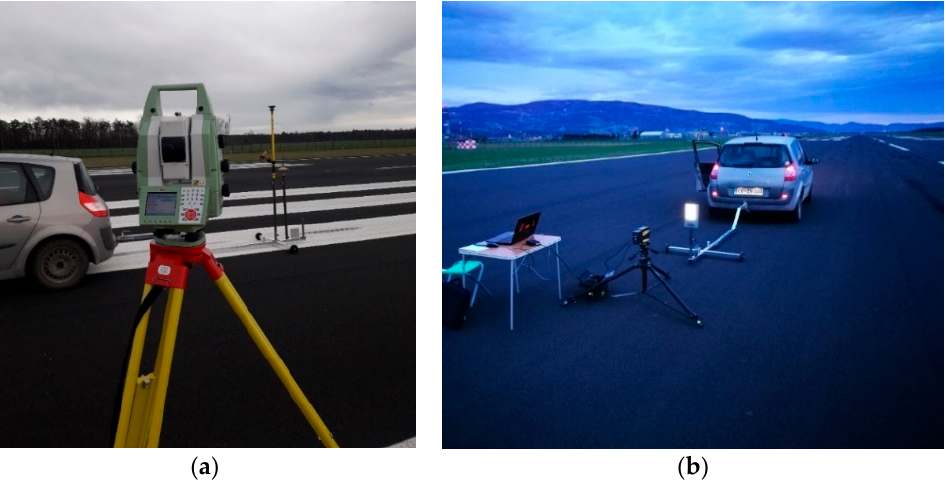
Figure 4. ( a , b ) Measuring equipment (a: Leica TS50) and unsprung trailer vehicle (b).